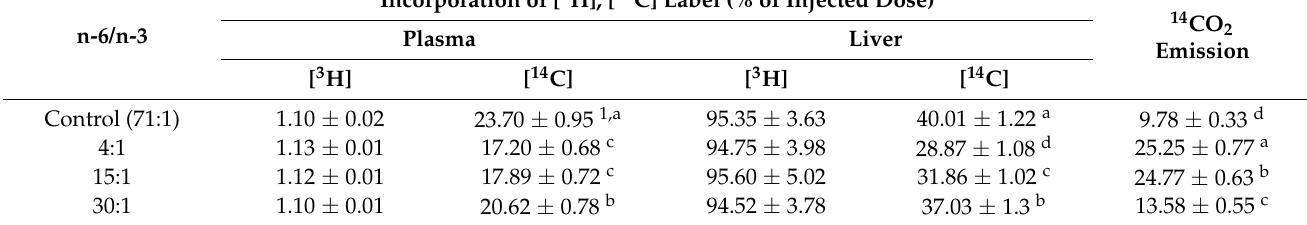
Table 1. Emission of 14 CO 2 and incorporation of [ 3 H], [ 14 C] label into liver and plasma at 60 min after injection of LPS (d < 1.015) labelled with cholesteryl [ 14 C]-oleate in obese animal biomodel rat-fed diets containing different n-6/n-3.